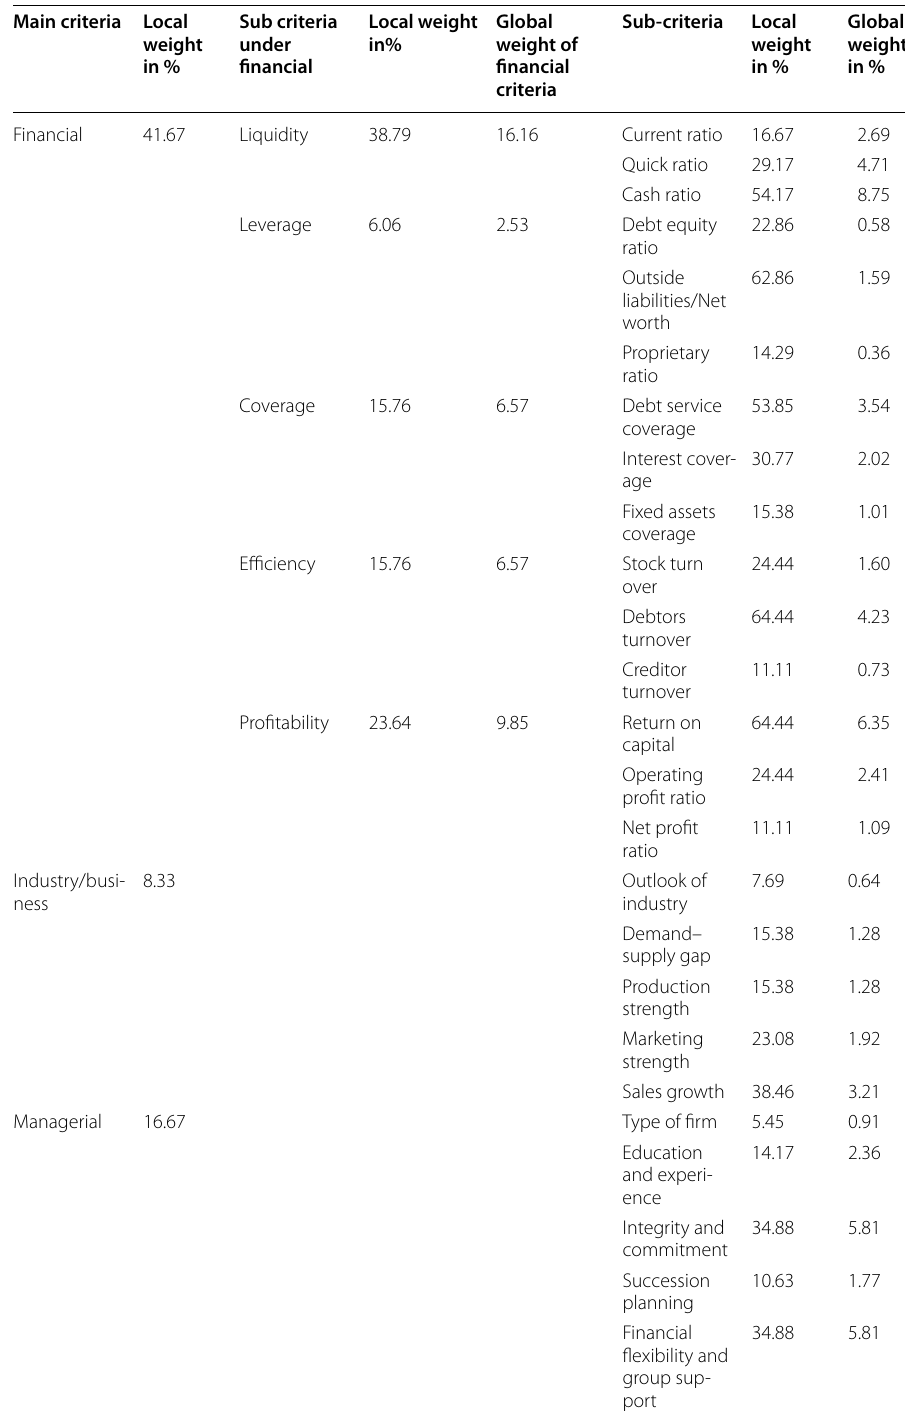
Table 5 Final weights of criteria and sub-criteria using BWM Main criteria Local